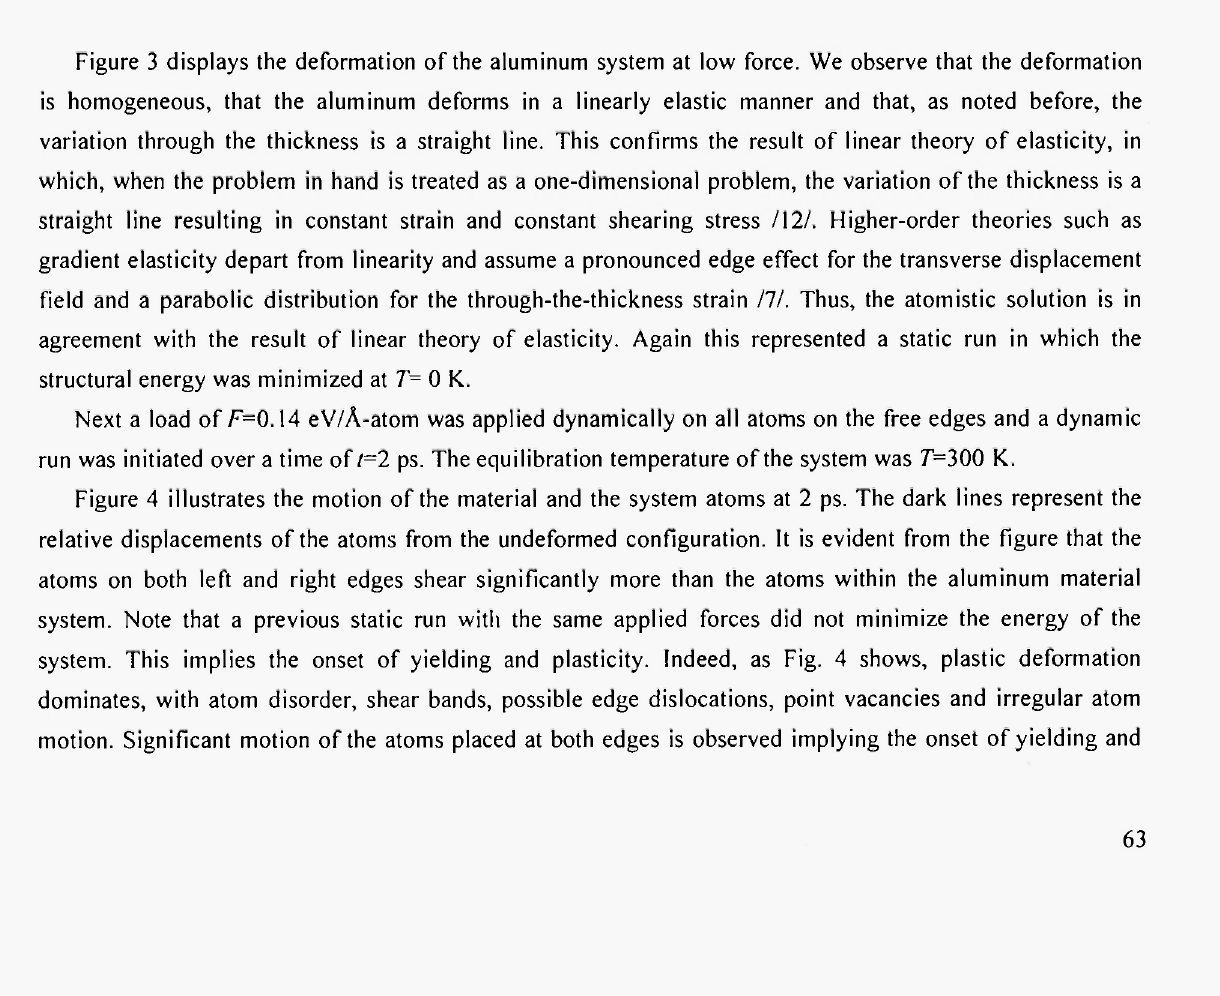
Fig. 2: Through-the-thickness displacement variation for different values of the applied forces, at T= 0